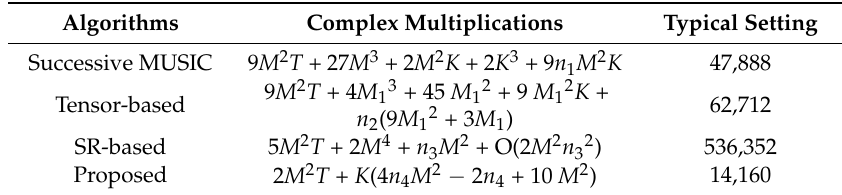
Table 2. Complexity